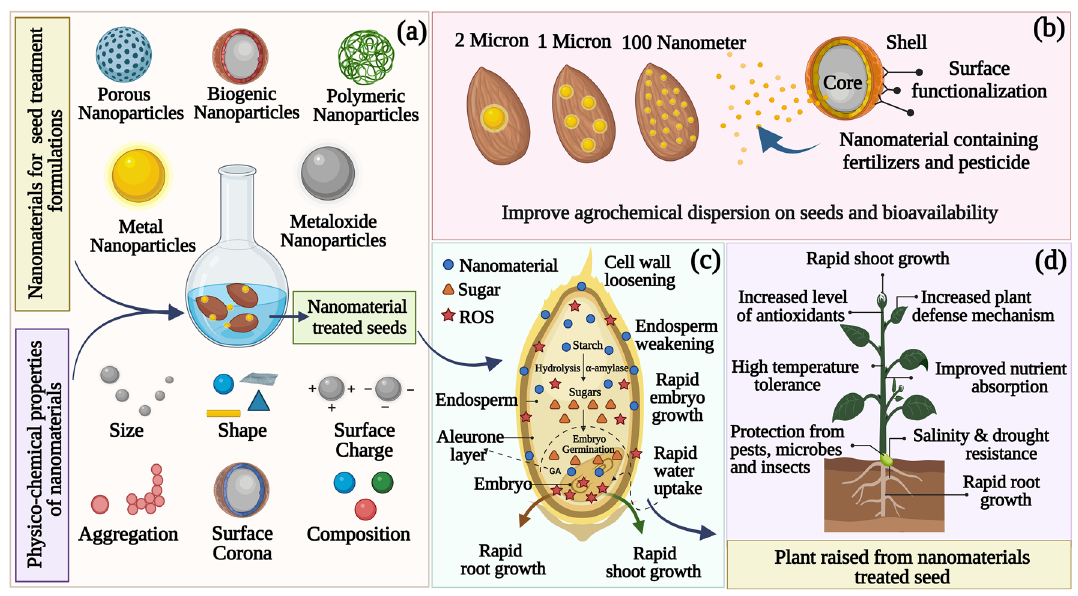
Fig. 1 Application of organic–inorganic nanomaterials in seed germination and plant development. a Nanoparticles’ properties (such as size, shape, surface charges, composition, and concentration) affecting the seed interaction. b Surface-engineered nanoparticles with the desirable properties for seed treatments. c Nanoparticles induced seed metabolism. d Nanoparticles effect for the improved growth and establishment of